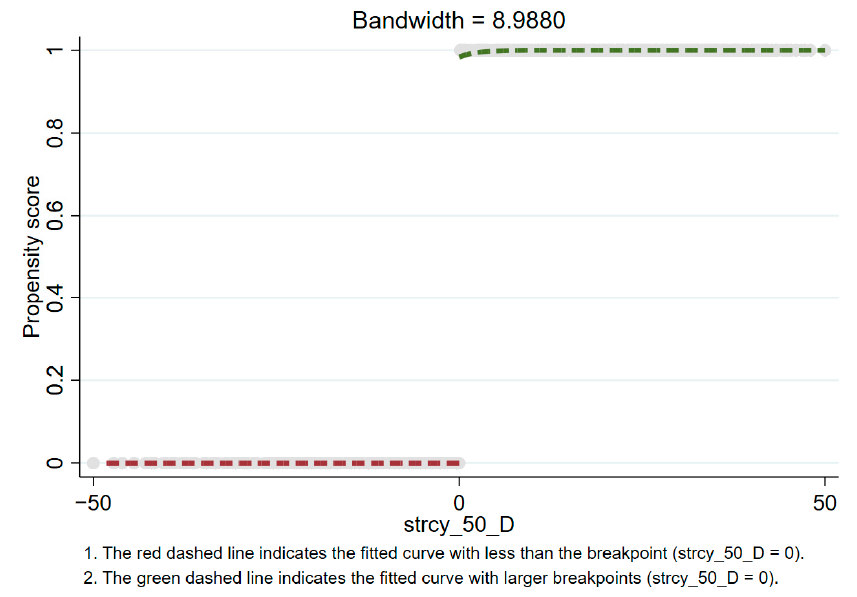
Healthcare 2020 , 8 , x Figure 5. Propensity score at stringency = 50 (based on fuzzy breakpoint regression).